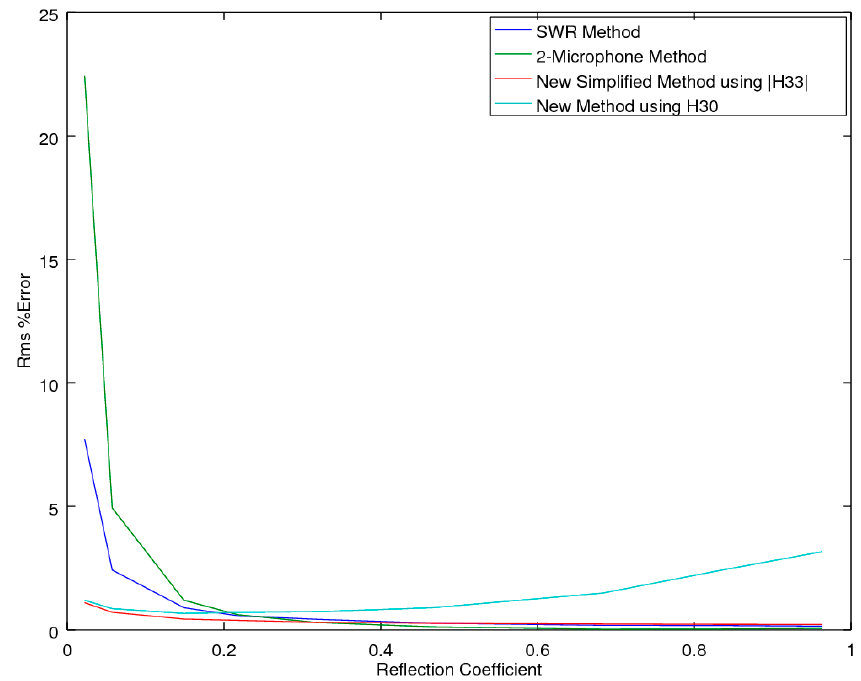
Figure 6. Comparison of accuracy from the computation of R, with a normalized noise level of 0.005 and a β value of 2.0. Comparison is between the two standard methods, SWR [2] and the two-microphone method [5,6], and the technique utilized in the three-microphone method [14], versus the new proposed methods utilizing the simplified |H 33 | method (amplitude only measurements) and the technique that uses a measurement of H 30 (complex measurements that include phase relationships).